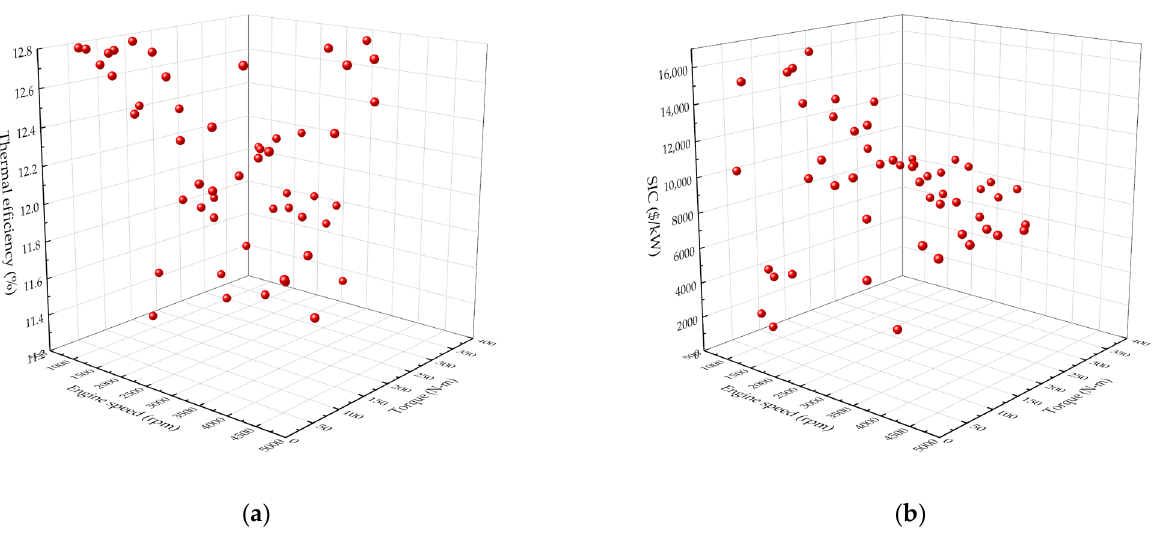
Figure 13. The optimization results of the two objectives: ( a ) thermal efficiency; ( b ) SIC.